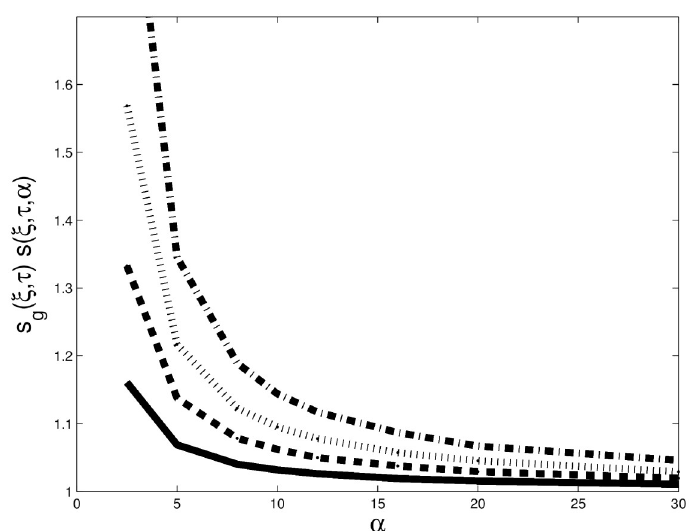
Fig 4. Sensitivity of s g ( ξ , τ ) s ( ξ , τ , α ) to α and ξ . Sensitivity of the nonlinear correlation to α for the Student- t distribution. The tail index varies from 2.5 to 30. Each line is for a value of ξ : 0.90 (solid line), 0.95 (thick dashes), 0.975 (thin dashes) and 0.99 (thick and thin